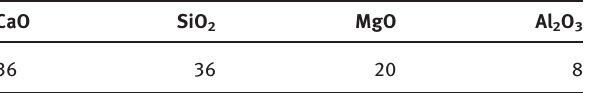
Table 2: Composition of initial slag/mass%.